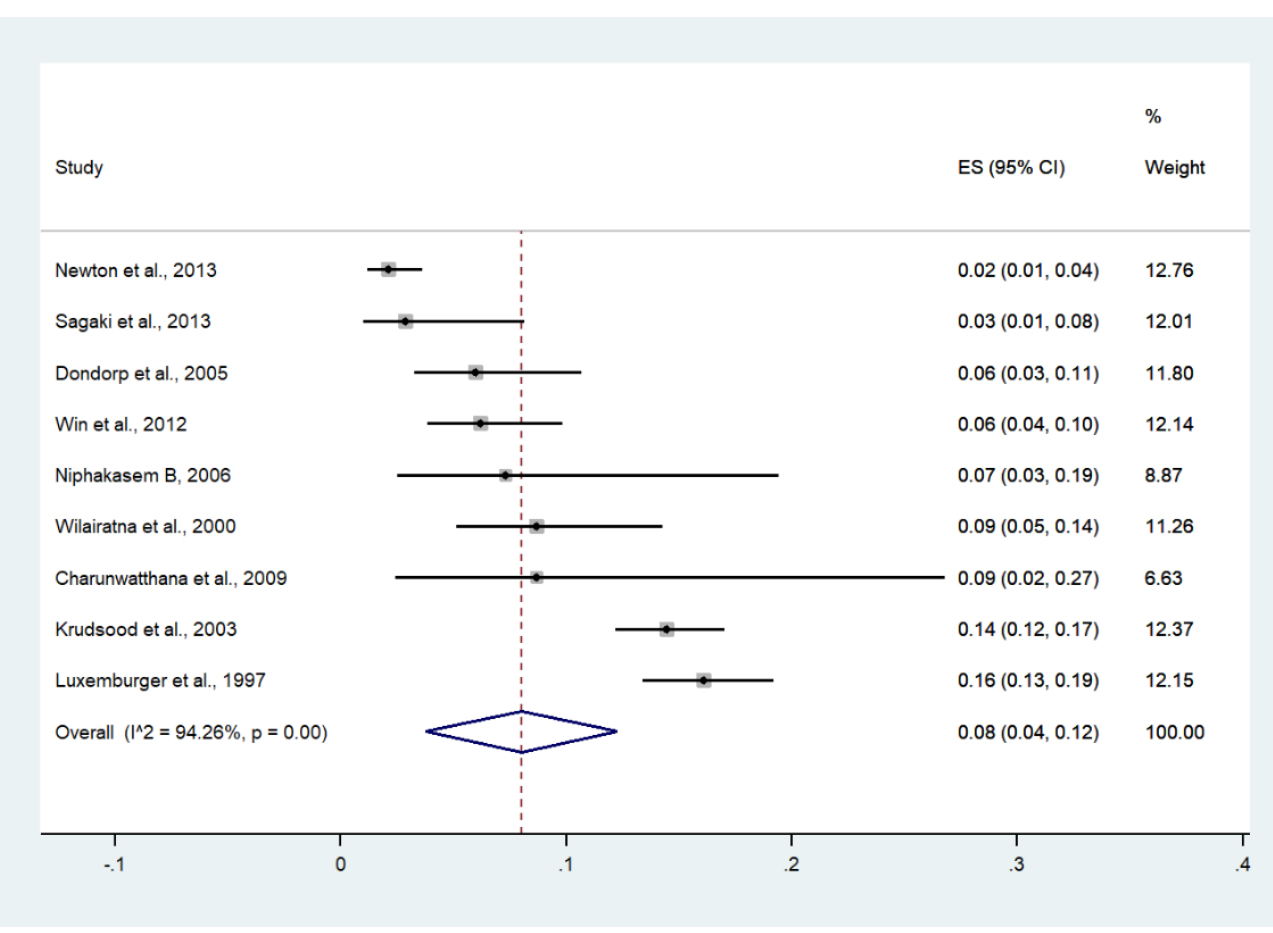
Figure 11. The pooled prevalence of severe anemia among patients with severe malaria in Thailand. The label for the x-axis is the scale of estimated prevalence. Abbreviations; ES, estimated prevalence; CI, confidence interval .